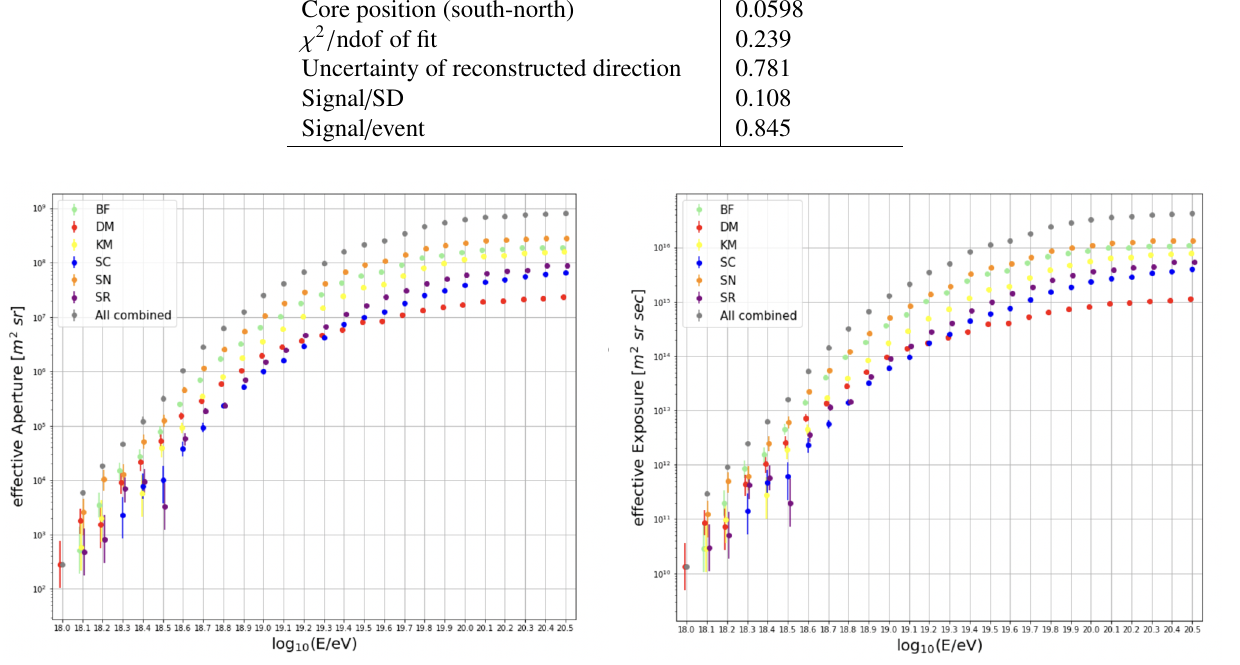
Figure 4: The e ff ective aperture (a) and the e ff ective exposure (b) of TAx4 SDs. The gray circles denote the total TAx4 SD aperture(exposure) which consists of 6 sub-arrays (BF, DM, KM, SC, SN and SR as shown in Fig 1). The energy is MC generated energy without energy scaling.